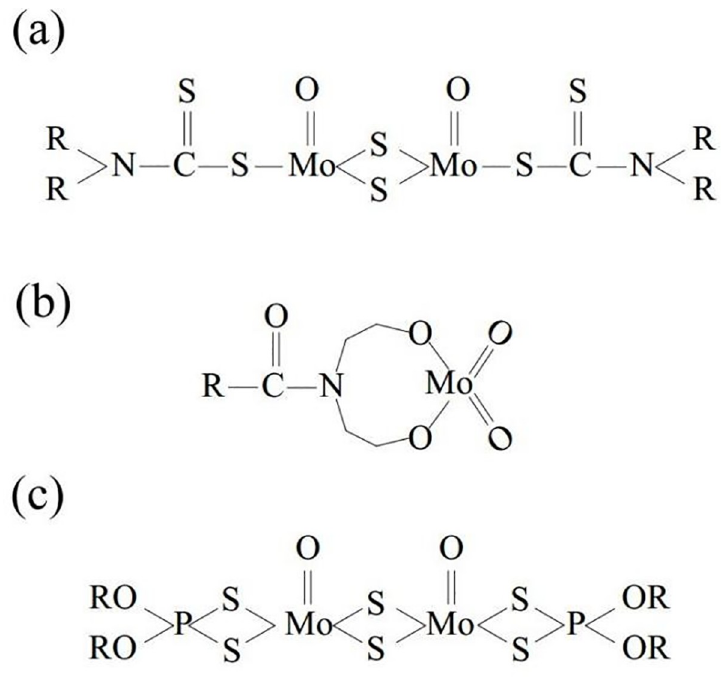
Fig 1. Molecular structures of organic molybdenum given by the suppliers. (a) molybdenum dithiocarbamate (MoDTC), (b) molybdenum amide (MA), and (c) Molybdenum dialkyldithiophosphate (MoDDP).